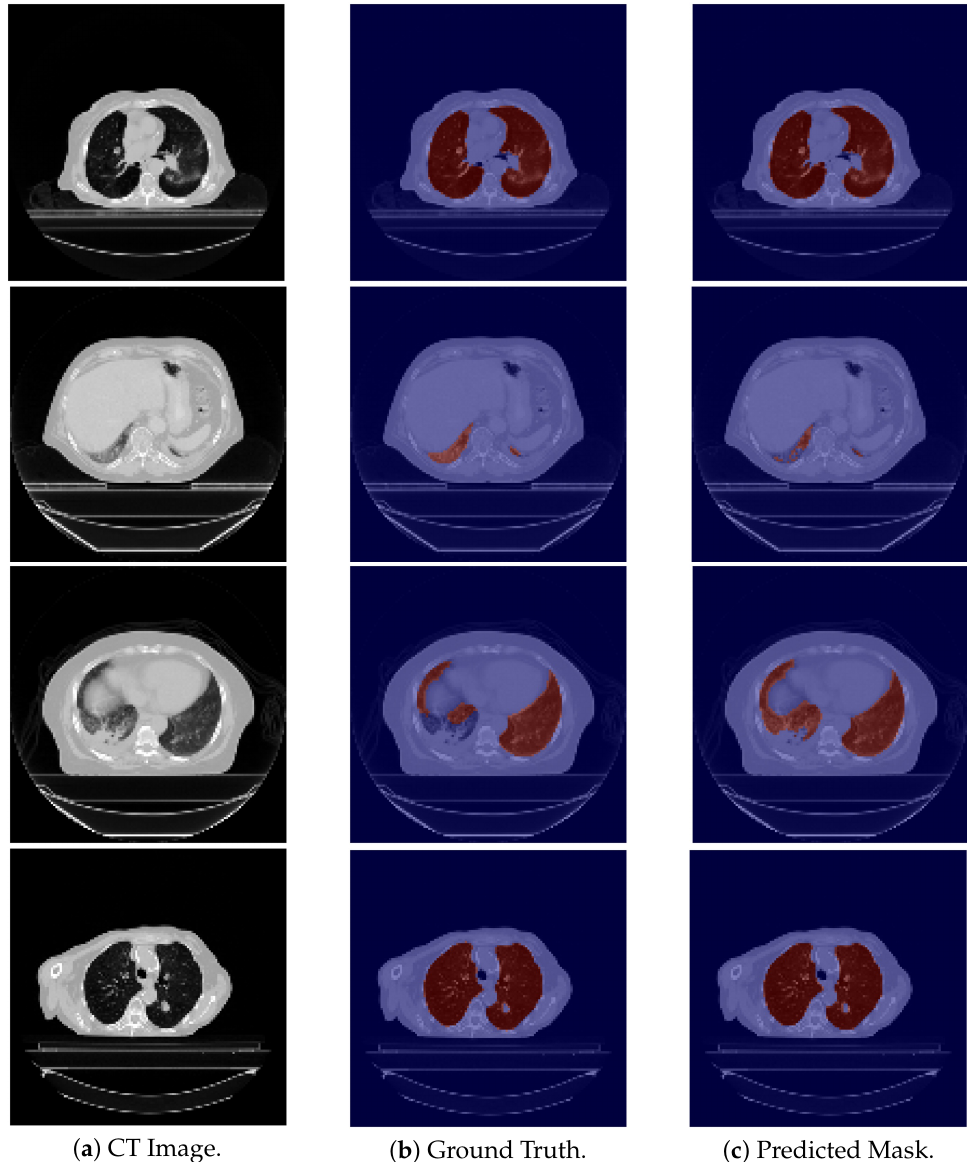
( b ) Ground Truth. ( c ) Predicted Mask. Figure 2. Examples of LCTSC images, the ground truth and the predicted mask. From top to bottom the examples are, respectively: good segmentation example; an example in which the model fails to segment the base of the lung; an example of a ground truth image that excludes part of the parenchyma of the lung; an example that excludes a nodule in its ground truth, and which is also misclassified by the